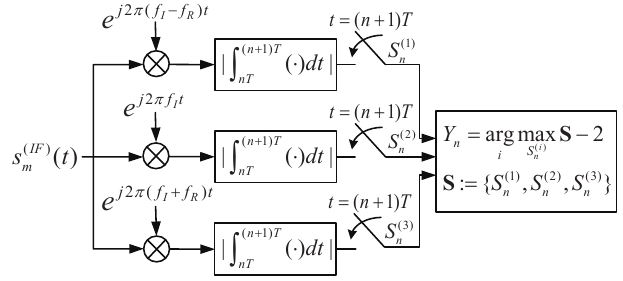
Figure 4. The proposed 1.5-bit FM demodulator.